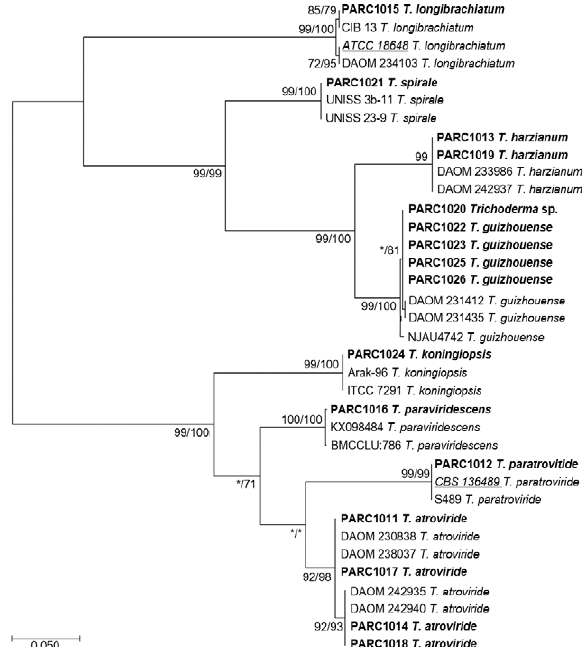
Figure 1. Greatest log likelihood ITS Neighbor-Join phylogenetic tree generated with 37 Trichoderma nucleotide sequences. Numbers in before and after each slash (/) represent, respectively, likelihood and parsimony bootstrap values from 1,000 replicates. Values rep- resented by asterisks were less than 70% bootstrap. Trichoderma isolates from southern Italy included in this study are indicated in bold. Ex-type isolates are indicated in underlined